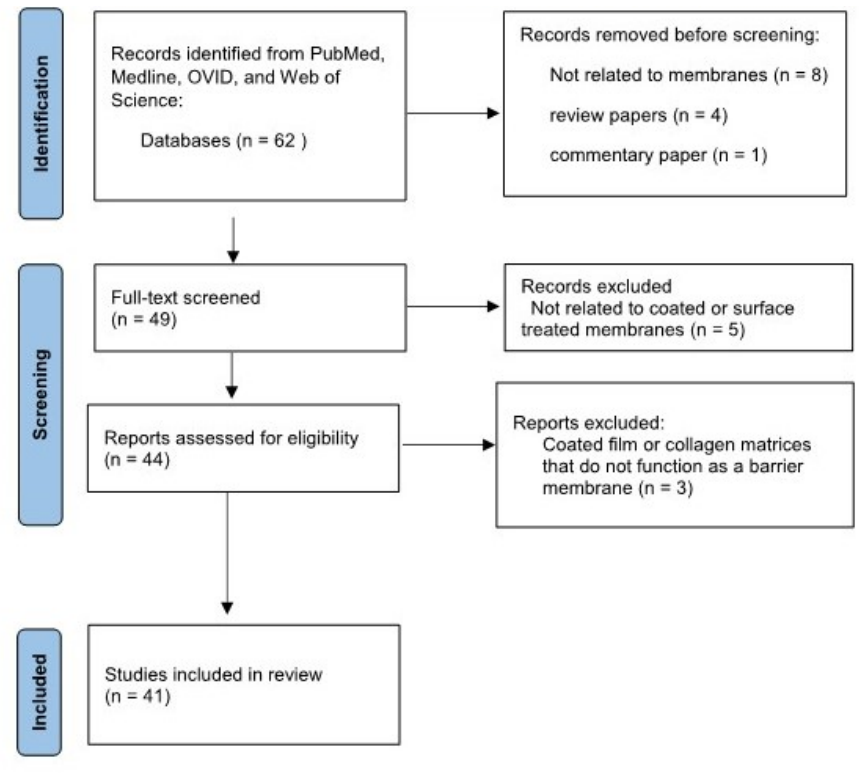
Figure 1. This is the flow chart of this study. Table 1. Summary of included studies on coated barrier membranes.